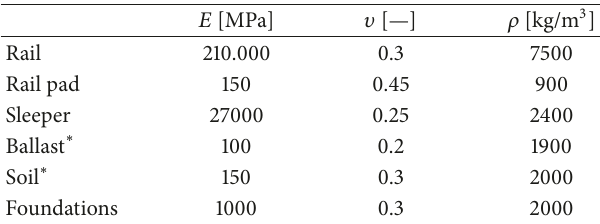
Table 1: Materials mechanical